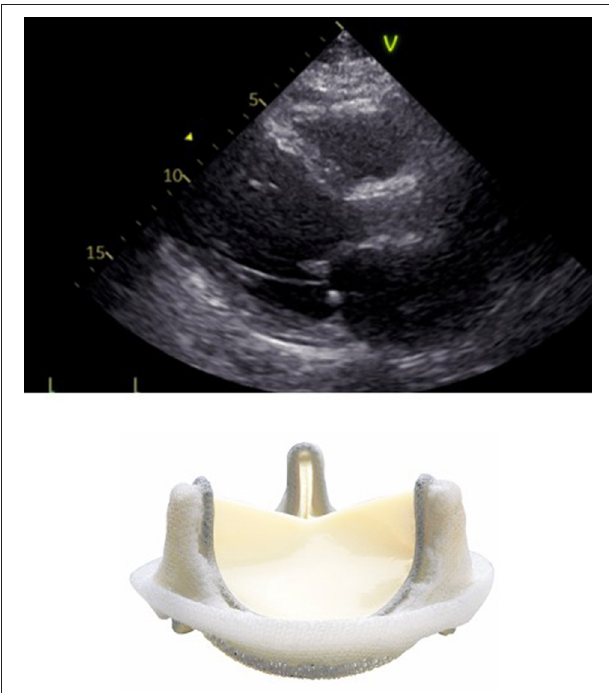
FIGURE 2 | Correct measurement of LVOT diameter below the inferior edge of the suture ring as indicated by the yellow bar in a surgical bioprosthetic valve (Perimount